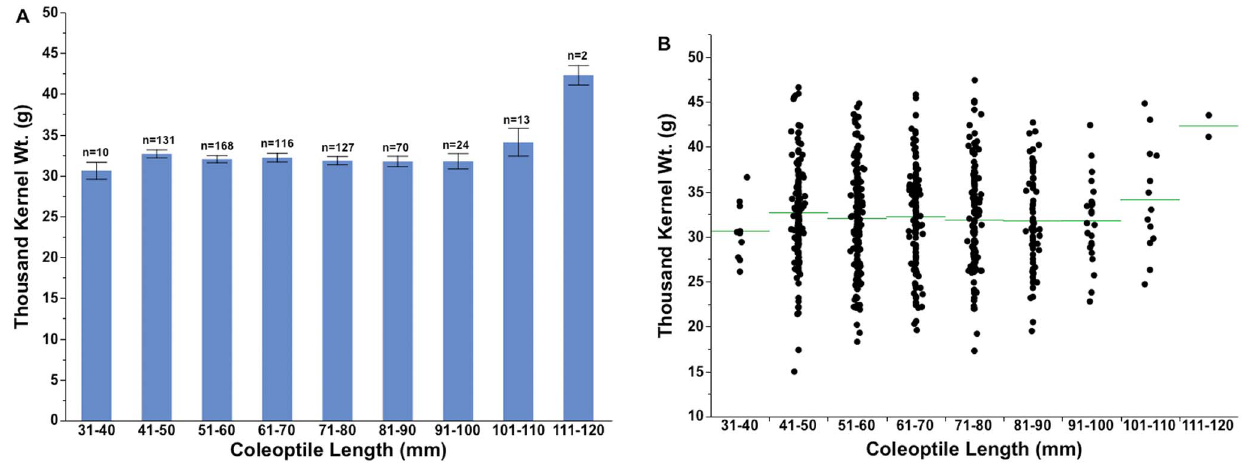
Figure 5. Thousand kernel weight distribution (A) and range variation (B) among different coleoptile length classes. Bars represent the standard error of the mean. The sample size (n) of each coleoptile class length is provided above the data bars. The horizontal line represents the mean in each coleoptile class (B).